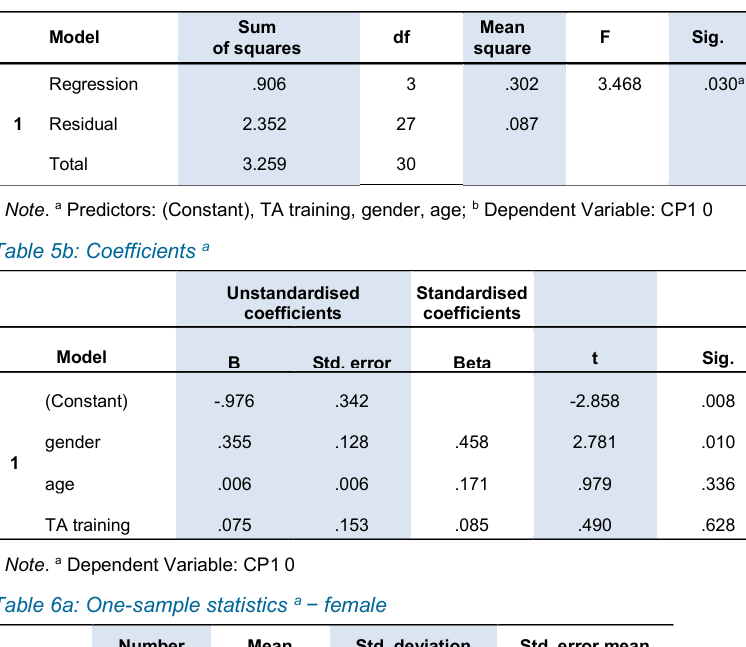
Table 5a: ANOVA b